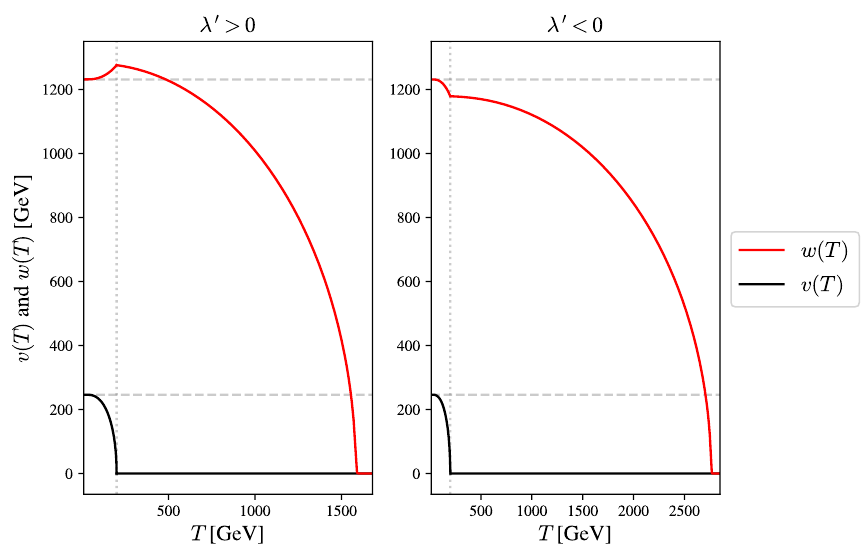
Figure 7 . Thermal evolution of the minimum of the effective potential in the SWSM. In the figure M s = 200 GeV , M N = 150 GeV , w 0 = 5 v 0 , and | λ 0 | = 0 . 0394 . With these parameters and within the OPT scheme the effective potential is real. The two panels differ in the sign of the mixing: in the left panel λ 0 > 0 and w 0 is approached from above, while in the right panel λ 0 < 0 and w 0 is approached from below as T → 0 . Note that apart from the qualitative difference at low temperatures, there is also a quantitative difference between the critical